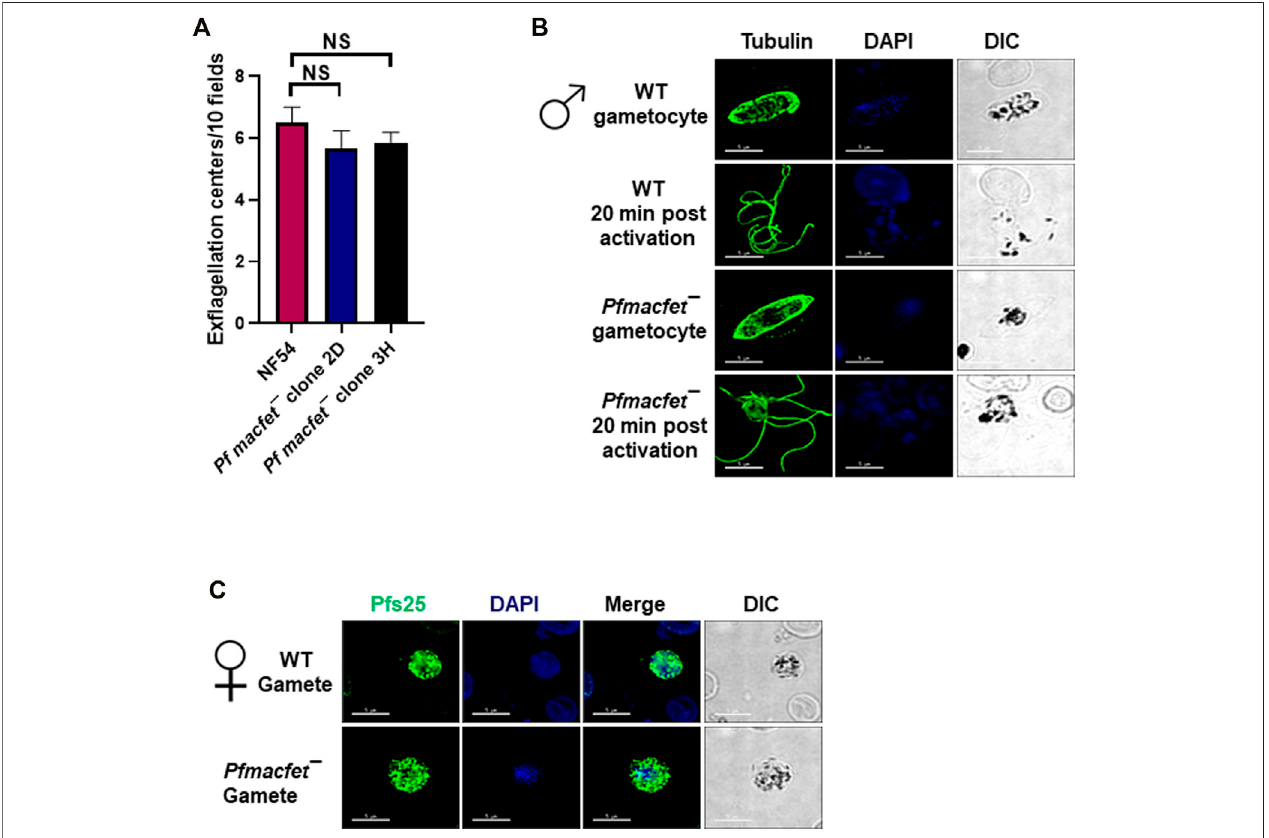
FIGURE5| Pfmacfet (cid:1) parasitesformmaleandfemalegametes. (A) Numberofex fl agellationcenters(vigorous fl agellarbeatingofmicrogametesinclustersofRBCs) per microscopic fi eld at 15 min post-activation. Data were averaged from three biological replicates and presented as the mean ± standard deviation (SD). (B) IFAs performed on thin blood culture smears for gametocytes activated for 20 min in vitro for WT Pf NF54 or Pfmacfet (cid:1) (clone 3H) using α -tubulin II (green), a male-speci fi c marker. α -Tubulin II staining showed microgametes emerging from ex fl agellating male gametocyte in both WT Pf NF54 and Pfmacfet (cid:1) gametocytes. (C) IFAs performed on thin blood culture smears for day 15 stage V gametocytes for WT Pf NF54 or Pfmacfet (cid:1) (clone 3H) using α - Pf s25 (green), a marker for female gametes. Representative images are shown. DIC, differential interference contrast. DAPI, 4 ′ ,6-diamidino-2-phenylindole, Scale bar = 5 μ m.